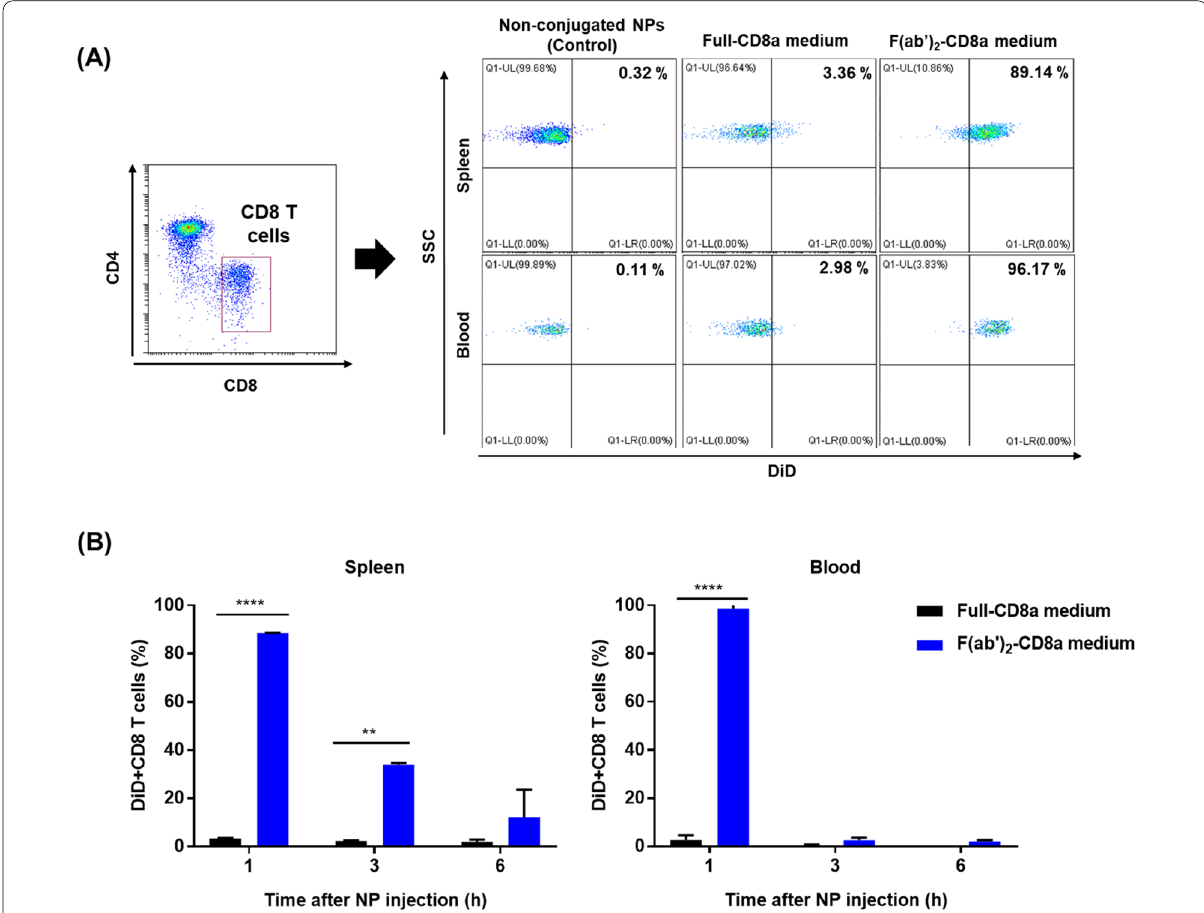
Fig. 4 CD8a T cell targeting efficiency of the f(ab ′ ) 2 ‑CD8a NPs‑medium in vivo. A Population of the DiD NPs are administered through IV injection and assessed through flow cytometry. B Clearance of the administered NPs observed by the variation of the population of the DiD CD8 T cells across prolonged circulation. Data were presented as the mean + ** P 0.0021, **** P < =